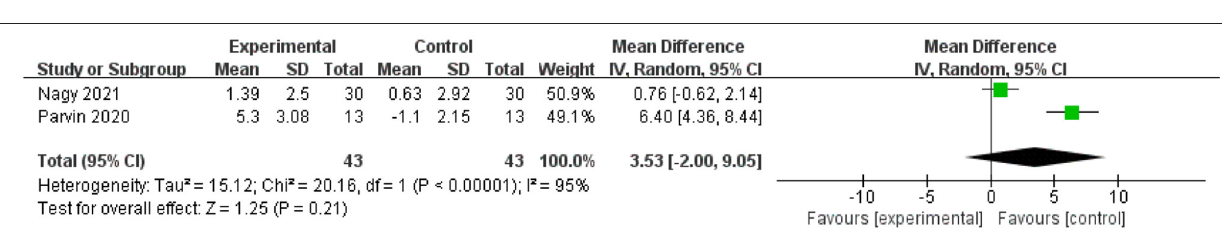
FIGURE 4 | Forest plot for physical exercise interventions on cognition function (ADAS-Cog).